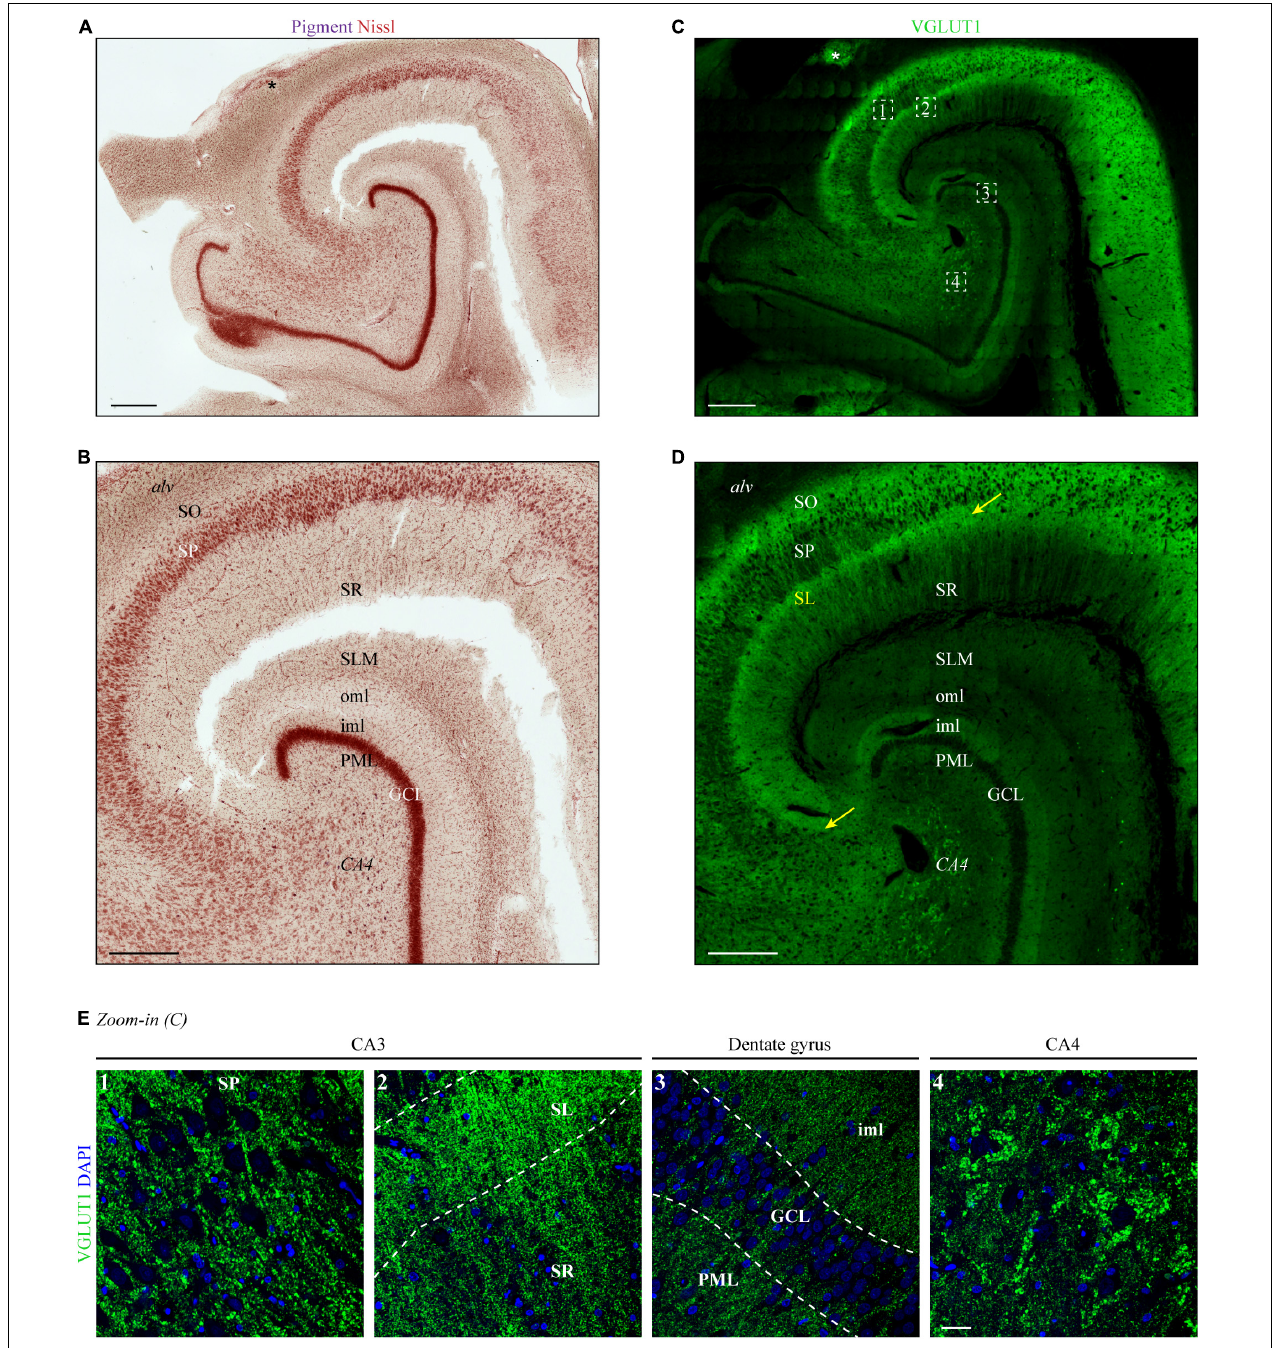
FIGURE 1 | Layers of the human hippocampus determined by VGLUT1 immunofluorescence and Nissl staining. (A) Lipofuscin (pigment, purple) and Nissl substance (red) were stained with aldehyde fuchsine and Darrow red in a human hippocampal section, occipital part. The asterisk marks adjoining parts of the gyrus fasciolaris . Scale bar, 700 µ m. (B) Zoom-in of panel (A) to display layer boundaries. Alv = alveus , SO = stratum oriens , SP = stratum pyramidale , SR = stratum radiatum , SLM = stratum lacunosum-moleculare , oml = outer molecular layer, iml = inner molecular layer, PML = polymorphic layer, GCL = granule cell layer, CA4 = cornu Ammonis region 4. Scale bar, 500 µ m. (C) A subsequent section from the tissue block used in panel (A) was immunostained with VGLUT1 and acquired at a confocal microscope. LAS-X Navigator was used to create and stitch the tilescan. Dashed squares (white) are shown in panel (E) as high-resolution z-stacks. The asterisk marks adjoining parts of the gyrus fasciolaris . Scale bar, 700 µ m. (D) Zoom-in of panel (C) to display layer boundaries. The yellow arrows mark the borders of the stratum lucidum (SL), i.e., CA3. Scale bar, 500 µ m. (E) Maximum intensity projections (MIPs) of high-resolution z-stacks (stack size = 2.64 µ m) acquired in the SP of CA3 (1), SL and SR of CA3 (2), dentate gyrus (3), and CA4 (4). Numbers refer to position 1–4 in the tilescan from panel (C) . Scale bar, 30 µ m. Images in panels (A–E) are derived from case 1.